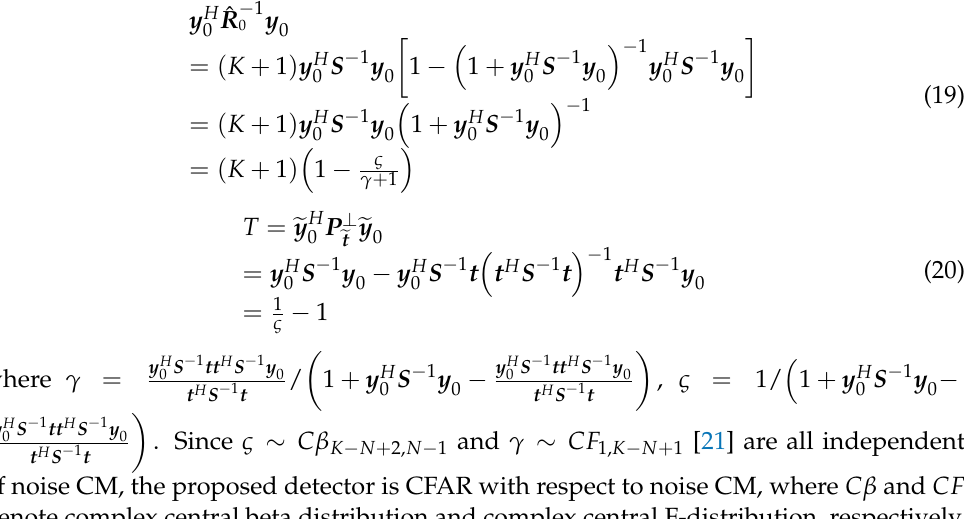
P versus ρ of gradient test; ( b ) fa